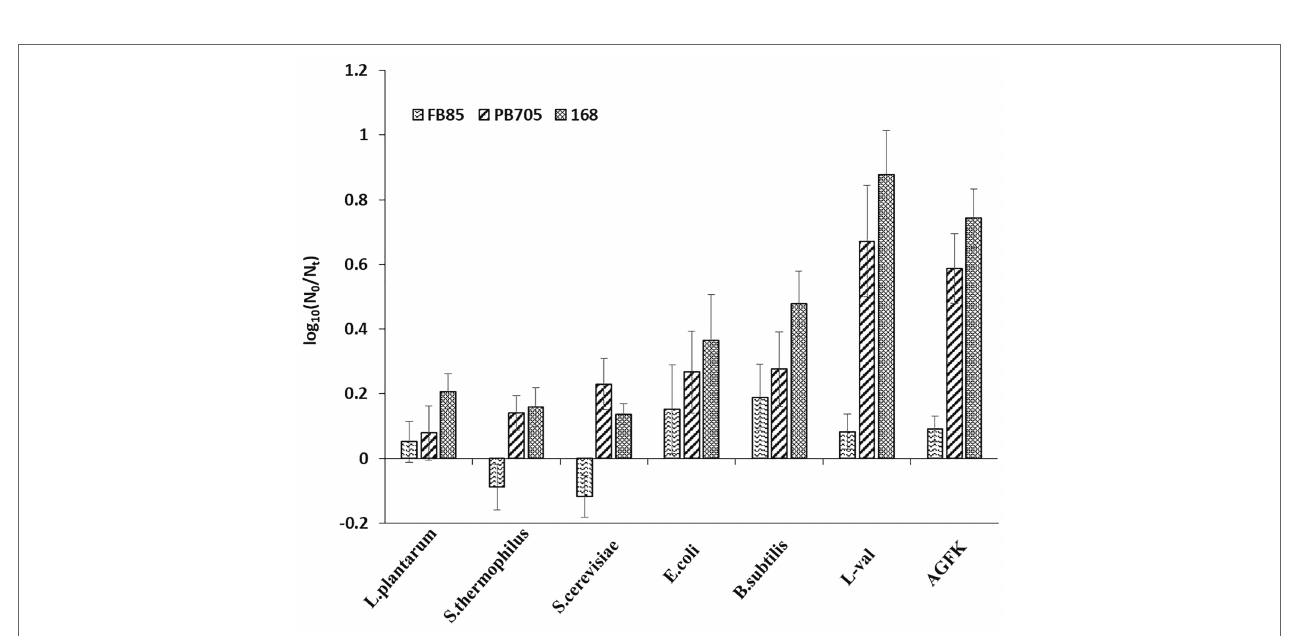
FIGURE 6 | The germination of B. subtilis 168, FB85, and PB705 spores with five microbial supernatants and two known germinants (L-val and AGFK). Bacillus subtilis FB85 was germination receptors (GRs) mutant strain, and B. subtilis PB705 was PrkC